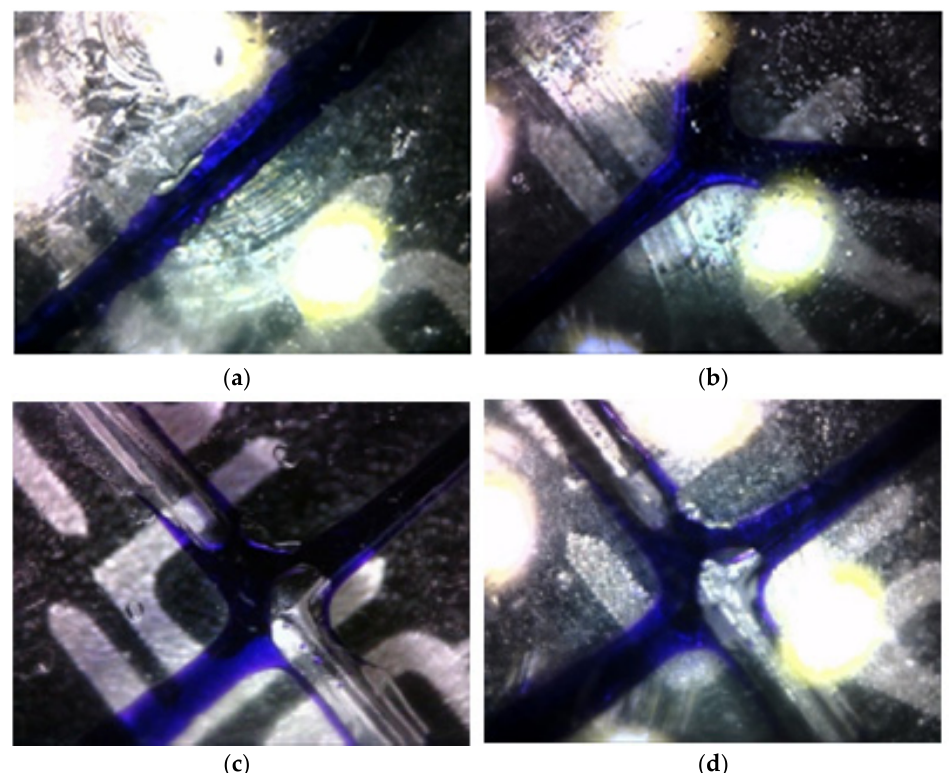
Figure 9. Experimental diagram of the tightness of chip. ( a , b ) drying for one hour; ( c , d ) heating in an oven at 75 °C.